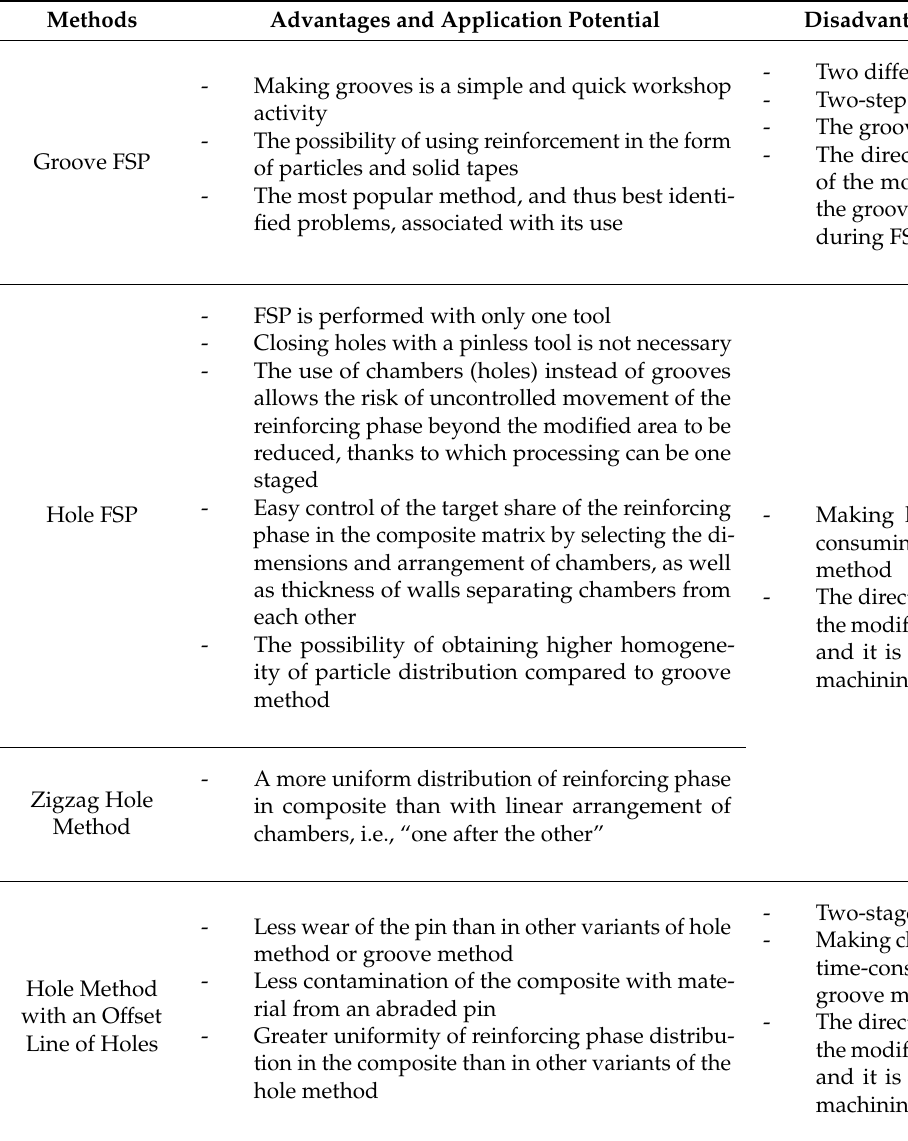
Table 6. Comparative characteristics of individual